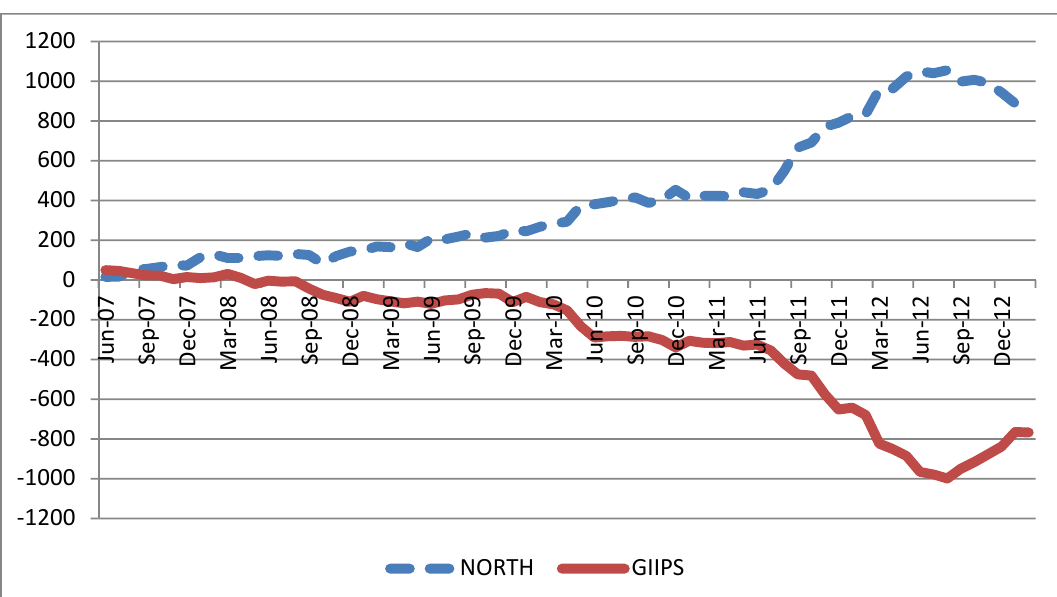
Figure 2. Net TARGET2 balance, bn €. Northern Eurozone, (Germany, Netherlands, Luxemburg and Finland) and of the